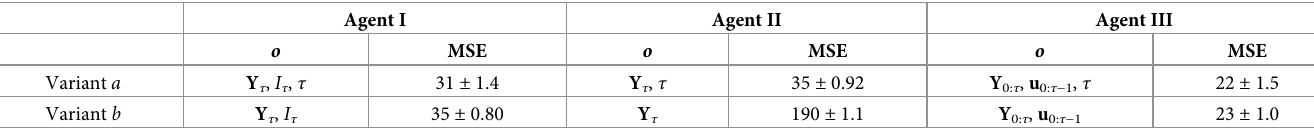
Table 3. Mean square error in predicted returns for six agents with different observation formulations. The agent with access to previous observation timeseries but no a priori knowledge of parameter values (formulation III) are able to accurately learn value estimates using the dynamics of the system. Error values are one standard deviation over five